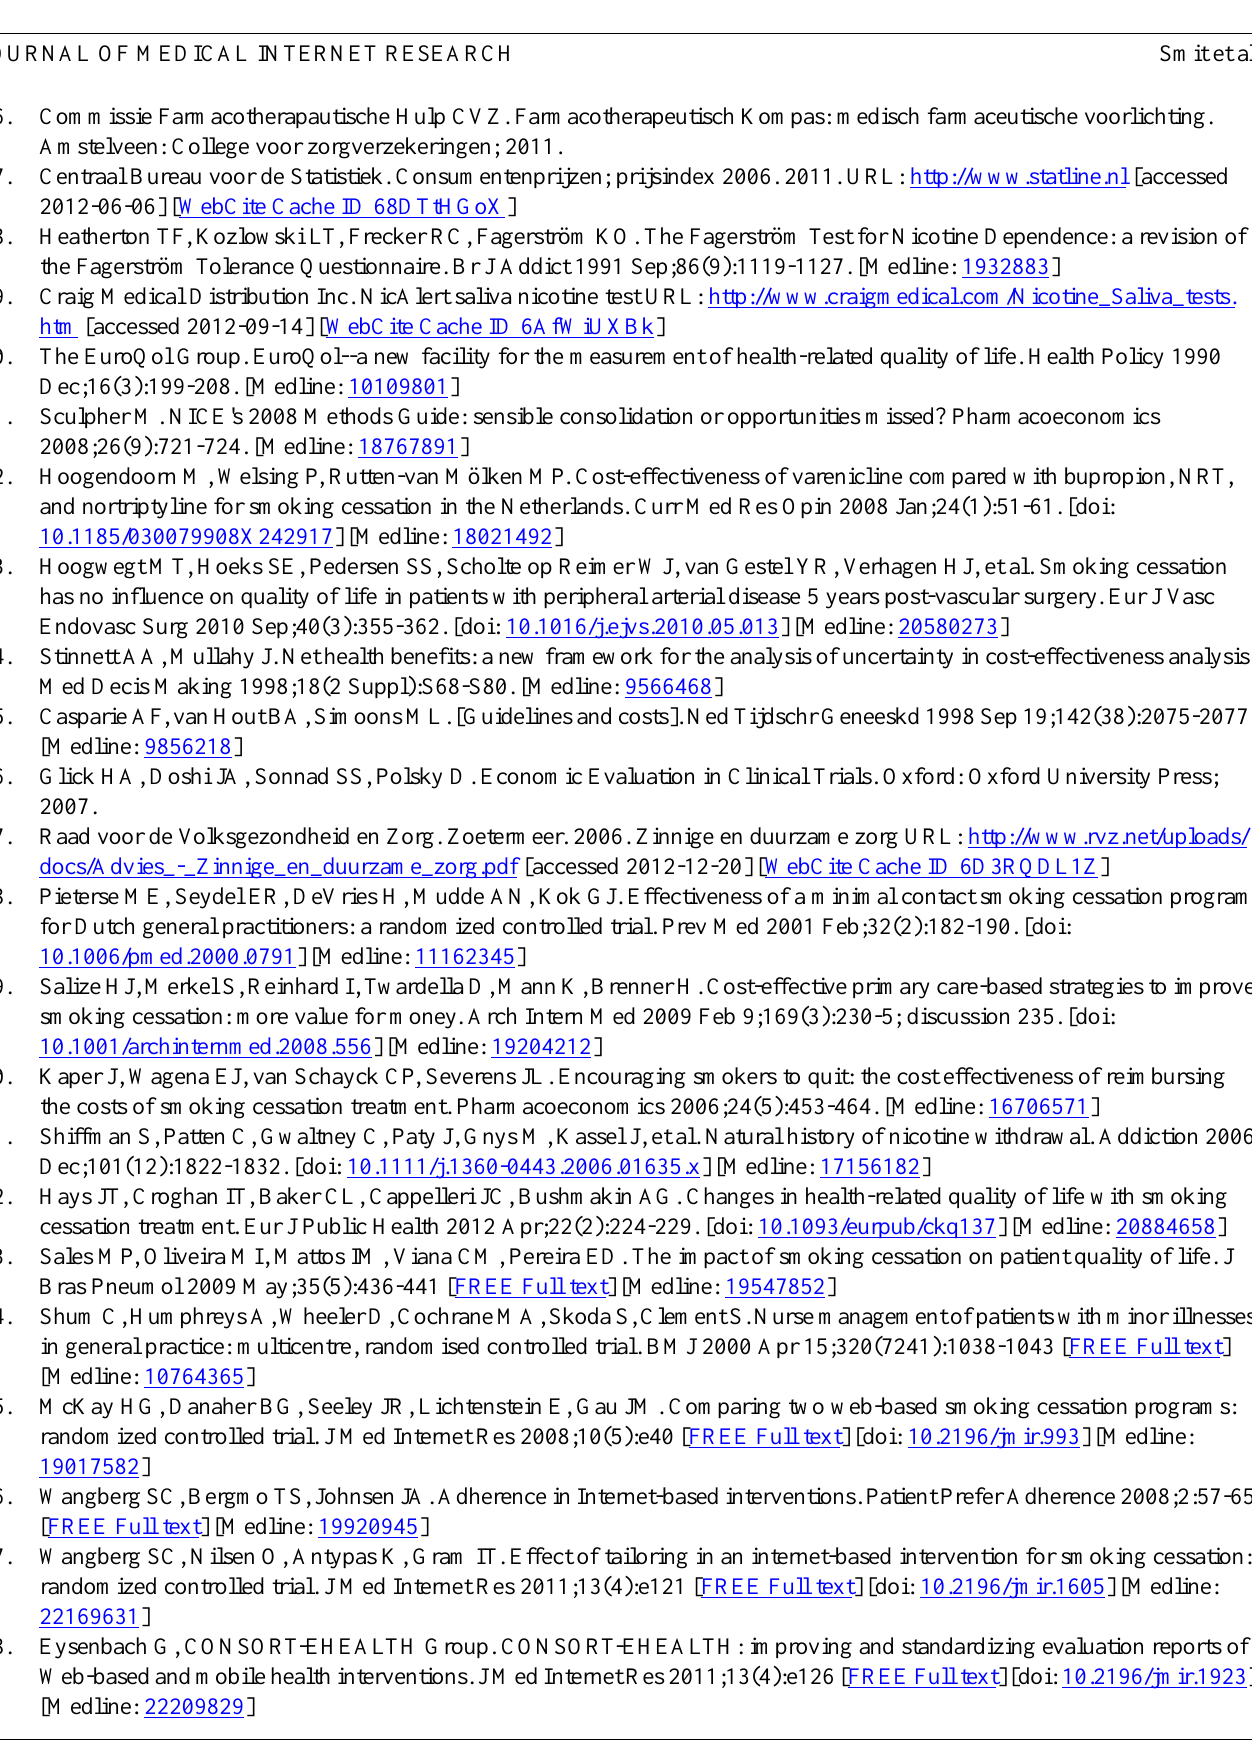
Abbreviations CEA: cost-effectiveness analysis CUA: cost-utility